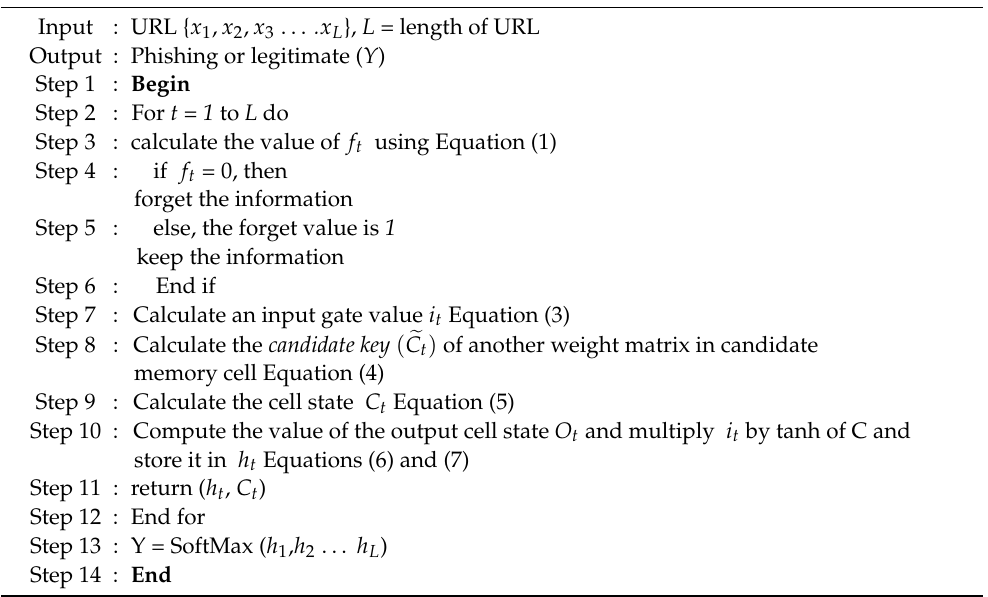
Algorithm 1: Regular LSTM for phishing URL